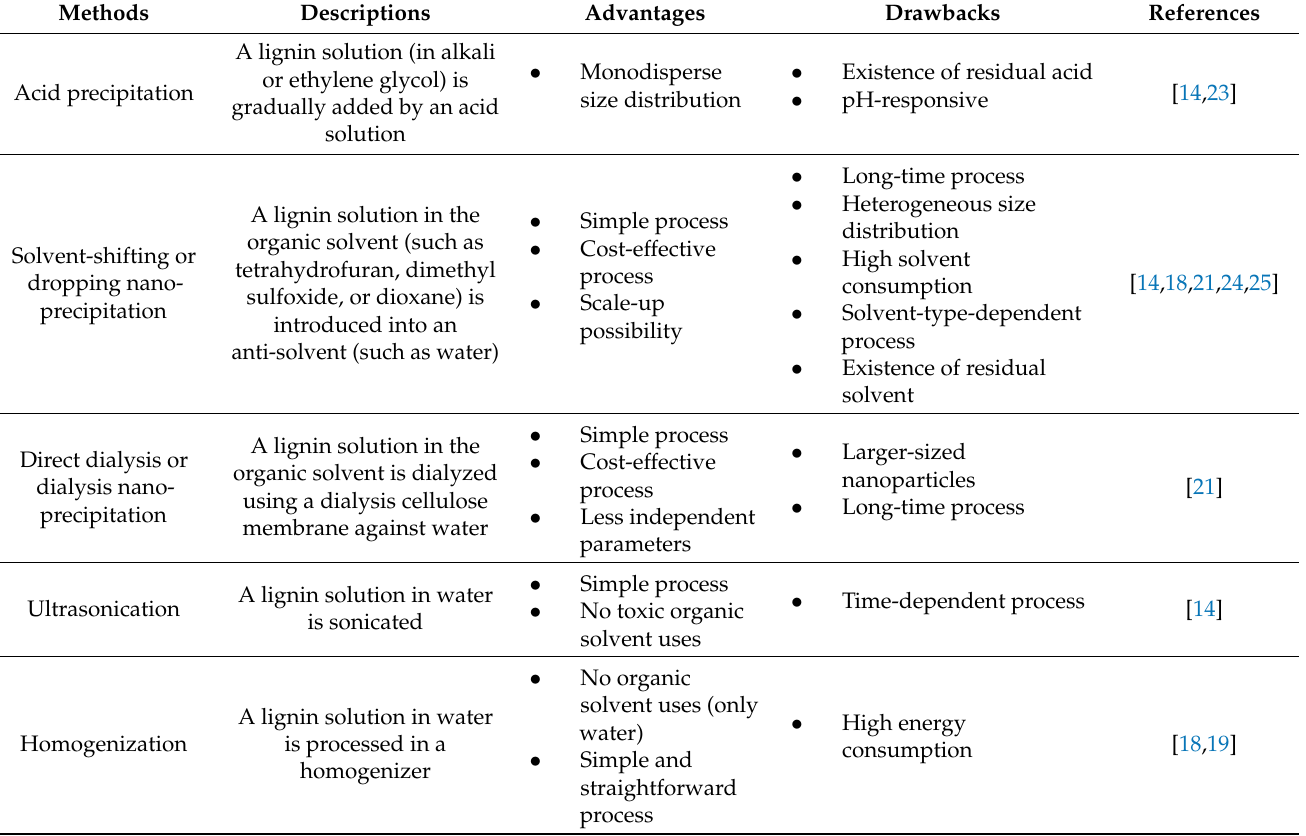
Table 1. Advantages and drawbacks of various LNPs synthesis